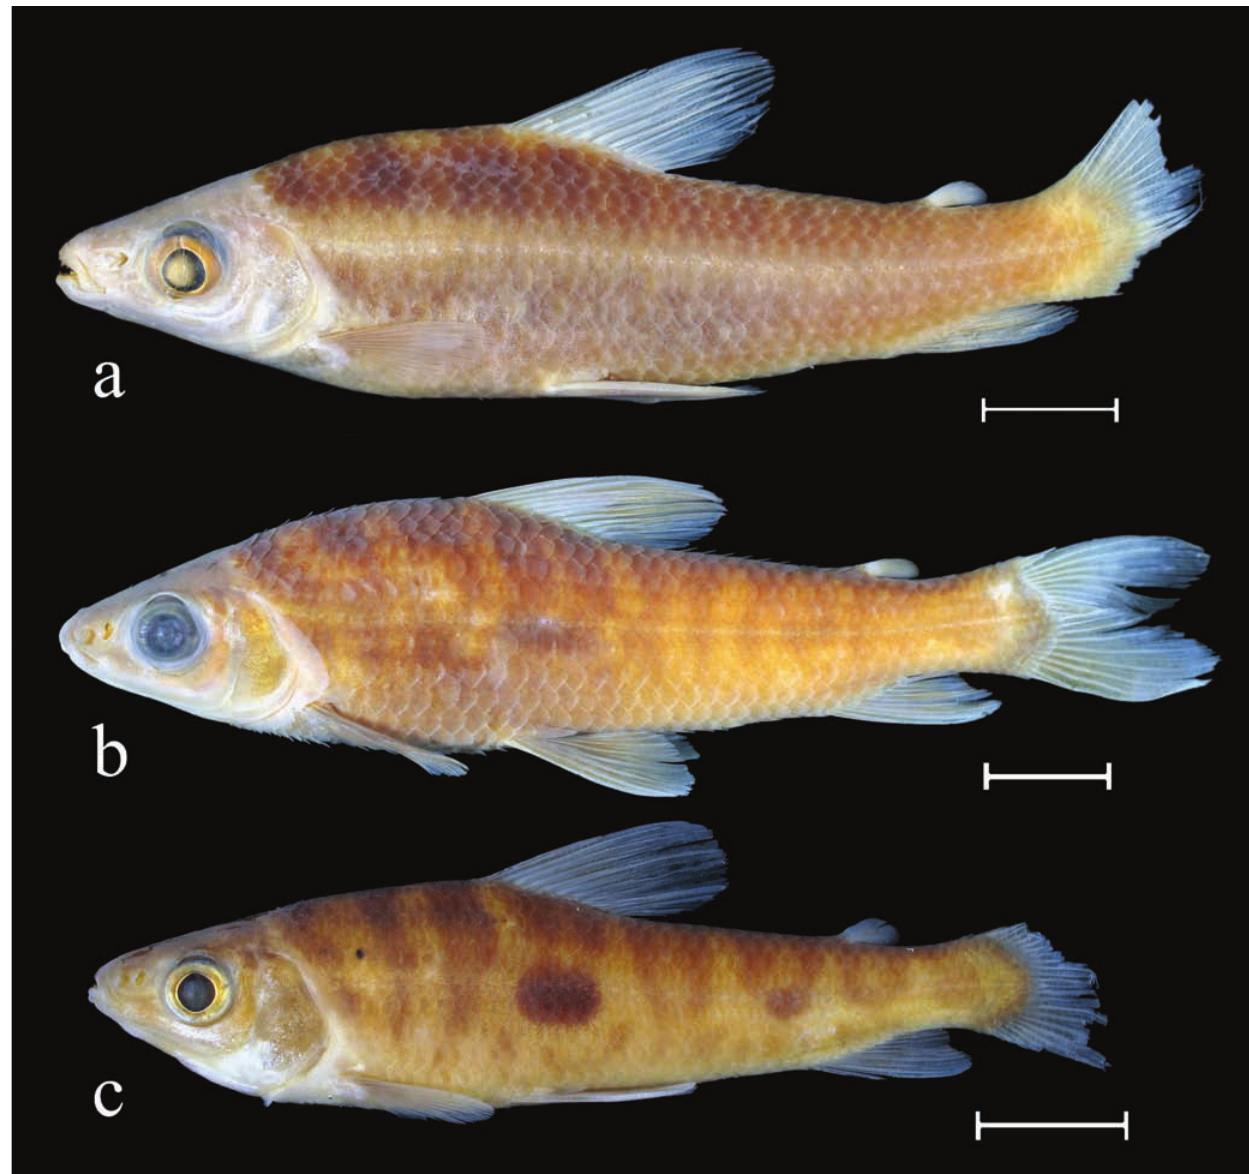
Fig. 1. Leporinus jamesi : (a) holotype, MCZ 20439, 73.8 mm SL, rio Solimões at Manacapuru; (b) MZUSP 48757, 70.4 mm SL, igarapé Manduaçu at Paraná de Iupiá; (c) MZUSP 75639, 59.4 mm SL, Paraná de Janauacá at entrance of Lago do Castanho. Scale bars = 10